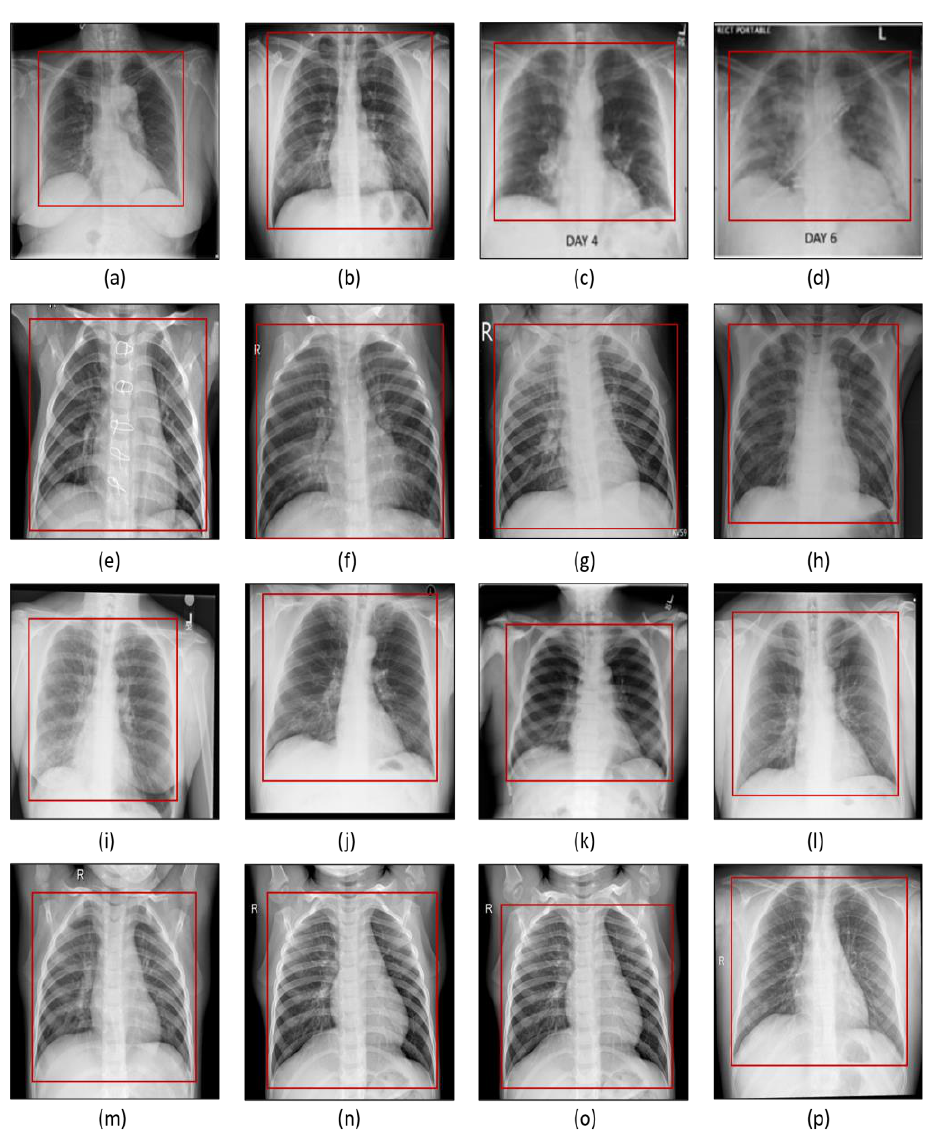
Figure 1. ( a – d ) COVID-19 chest X-ray, ( e – h ) pneumonia chest X-ray, ( i – l ) lung opacity chest X-ray, ( m – p ) normal chest X-ray. The red box signifies the region of interest cropped from the original image for analysis.